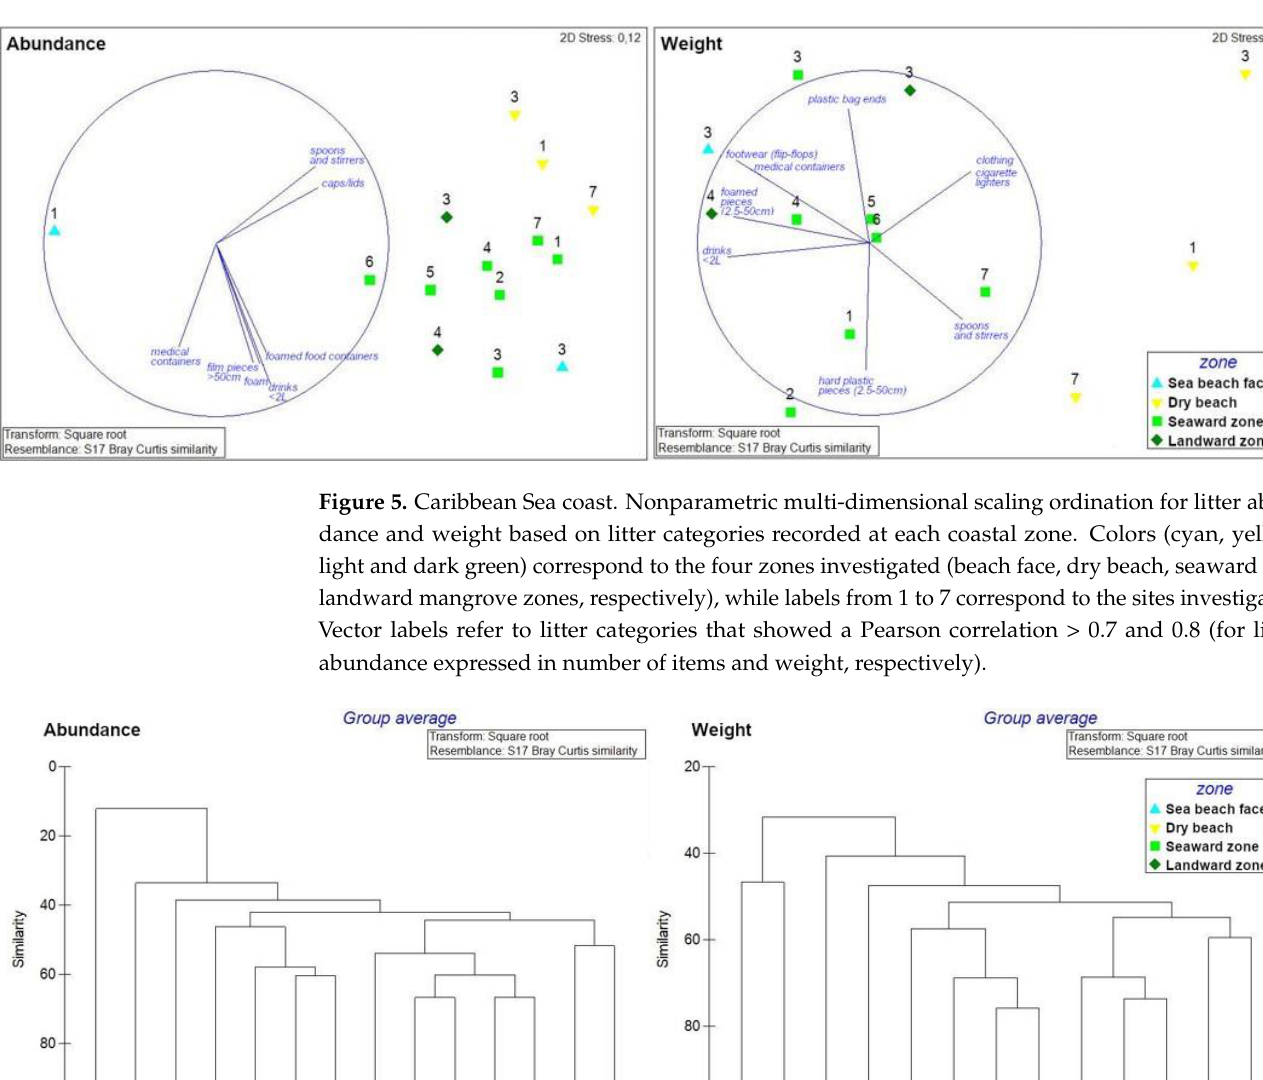
Figure 5. Caribbean Sea coast. Nonparametric multi-dimensional scaling ordination for litter abundance and weight based on litter categories recorded at each coastal zone. Colors (cyan, yel- low, light and dark green) correspond to the four zones investigated (beach face, dry beach, sea- ward and landward mangrove zones, respectively), while labels from 1 to 7 correspond to the sites investigated. Vector labels refer to litter categories that showed a Pearson correlation > 0.7 and 0.8 (for litter abundance expressed in number of items and weight, respectively).